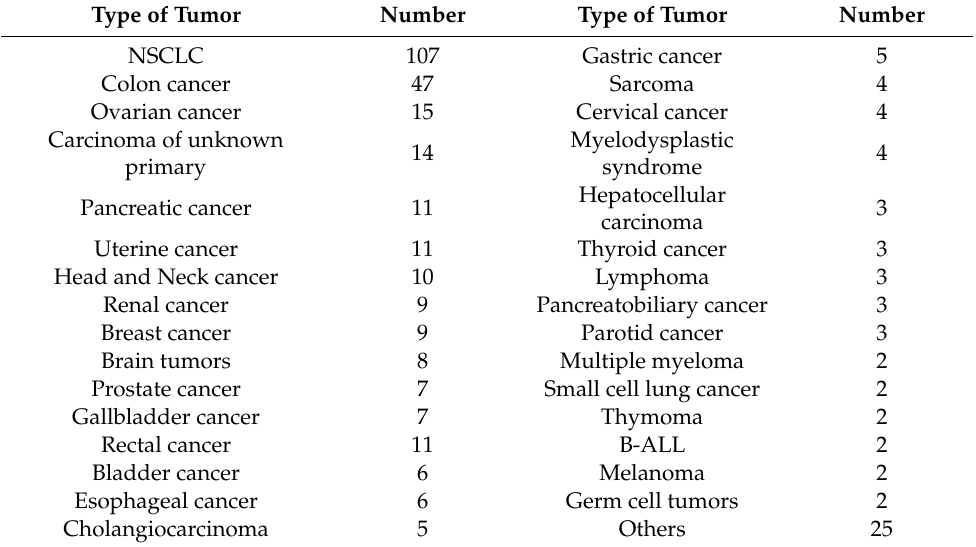
Table 1. Primary diagnosis for patients (Appendix, Online